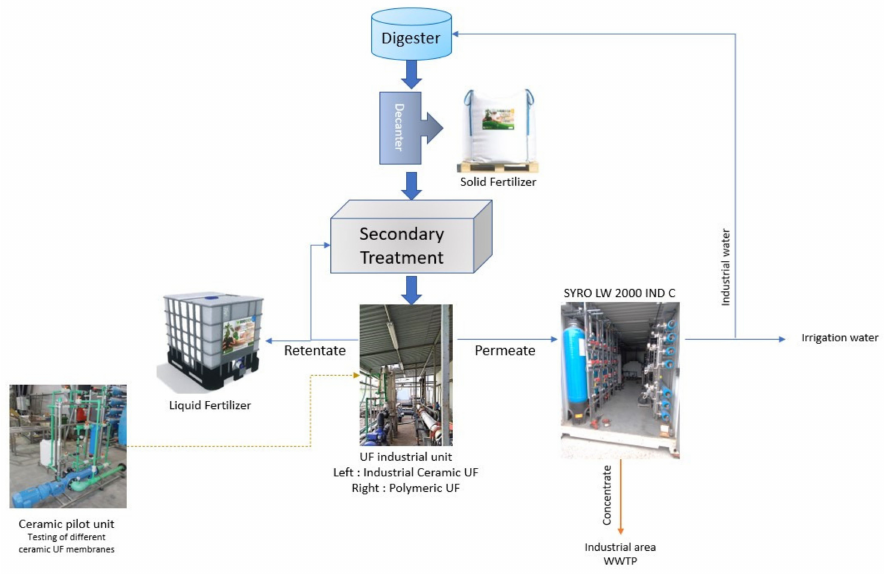
Scheme 1. Schematic representation of the proposed